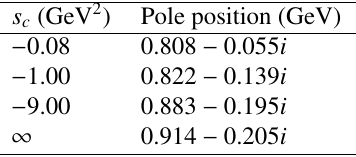
Figure 2. The phase shifts from r.h.i.c. in S 11 and P 11 channels. Table 1. The S 11 hidden pole fit with di ff erent choices of s c